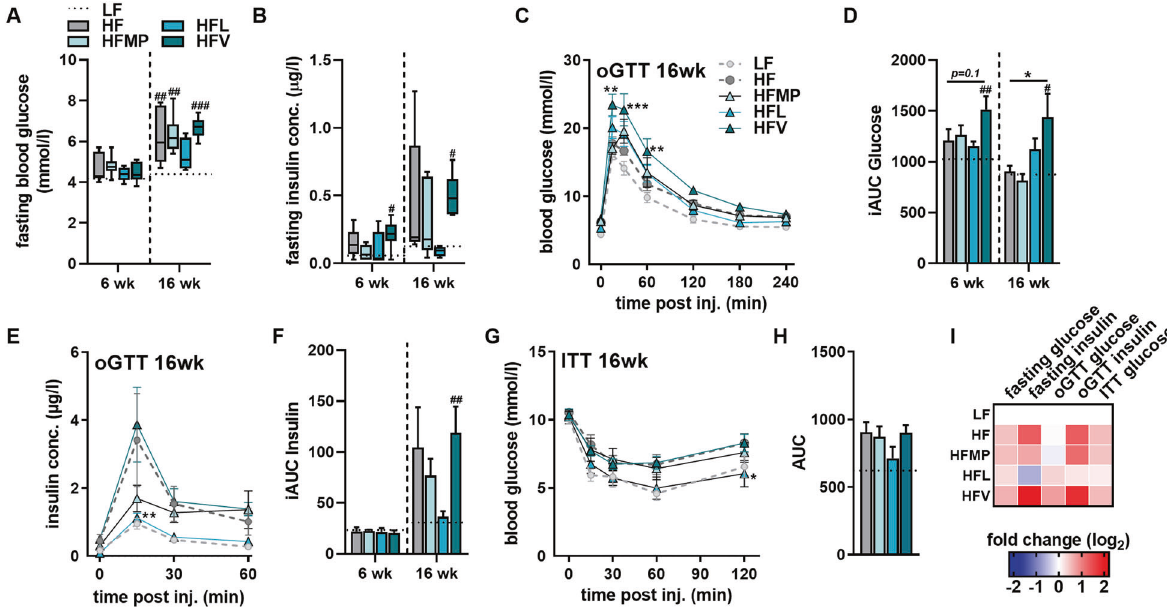
Fig. 2 Glucose clearance is impaired after long-term valine feeding, independent of glucose-stimulated insulin secretion. A Sixteen-hour fasting blood glucose in male C57BL/6 JRj mice fed low-fat (LF), high-fat (HF) or experimental HF diets supplemented with milk protein (HFMP), leucine (HFL) or valine (HFV) for 6 or 16 weeks ( n = 6 – 8). B Sixteen-hour fasting insulin at 6 or 16 weeks ( n = 6 – 8). C Glucose measurements during an oral glucose tolerance test (oGTT; oral gavage 2 g/kg body weight) after 16 h fast at 16 weeks of feeding ( n = 6 – 8). D Incremental area under the curve (iAUC) of glucose levels during oGTT at week 6 or 16 of experiment ( n = 6 – 8). E Insulin measurements during oGTT after 16 weeks of feeding ( n = 6). F Incremental area under the curve (iAUC) of insulin levels during oGTT at week 6 or 16 of experiment ( n = 6 – 8). G Glucose measurements during an insulin tolerance test (ITT; i.p. 0.75U insulin) after 2 h fast at 16 weeks ( n = 6). H Area under the curve (AUC) of glucose levels during i.p. ITT ( n = 6). I Heatmap of phenotypic effects. Plasma data ( A , B ) are expressed as interleaved box and whiskers (min to max) plots. All other data are shown as mean + SEM. LF is represented as dotted line. * p < 0.05; ** p < 0.01; *** p < 0.001 compared to HF and # p < 0.05; ## p < 0.01; ### p < 0.001 compared to